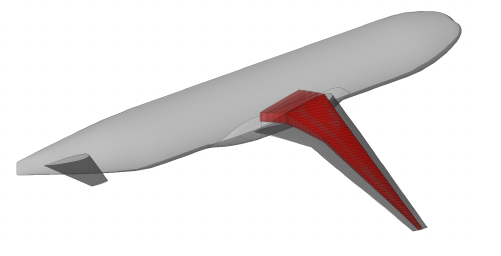
Figure 1. Baseline ESP representation of the uCRM geometry, with grey and red showing outer mold line (OML) and inner mold line (IML) geometries,